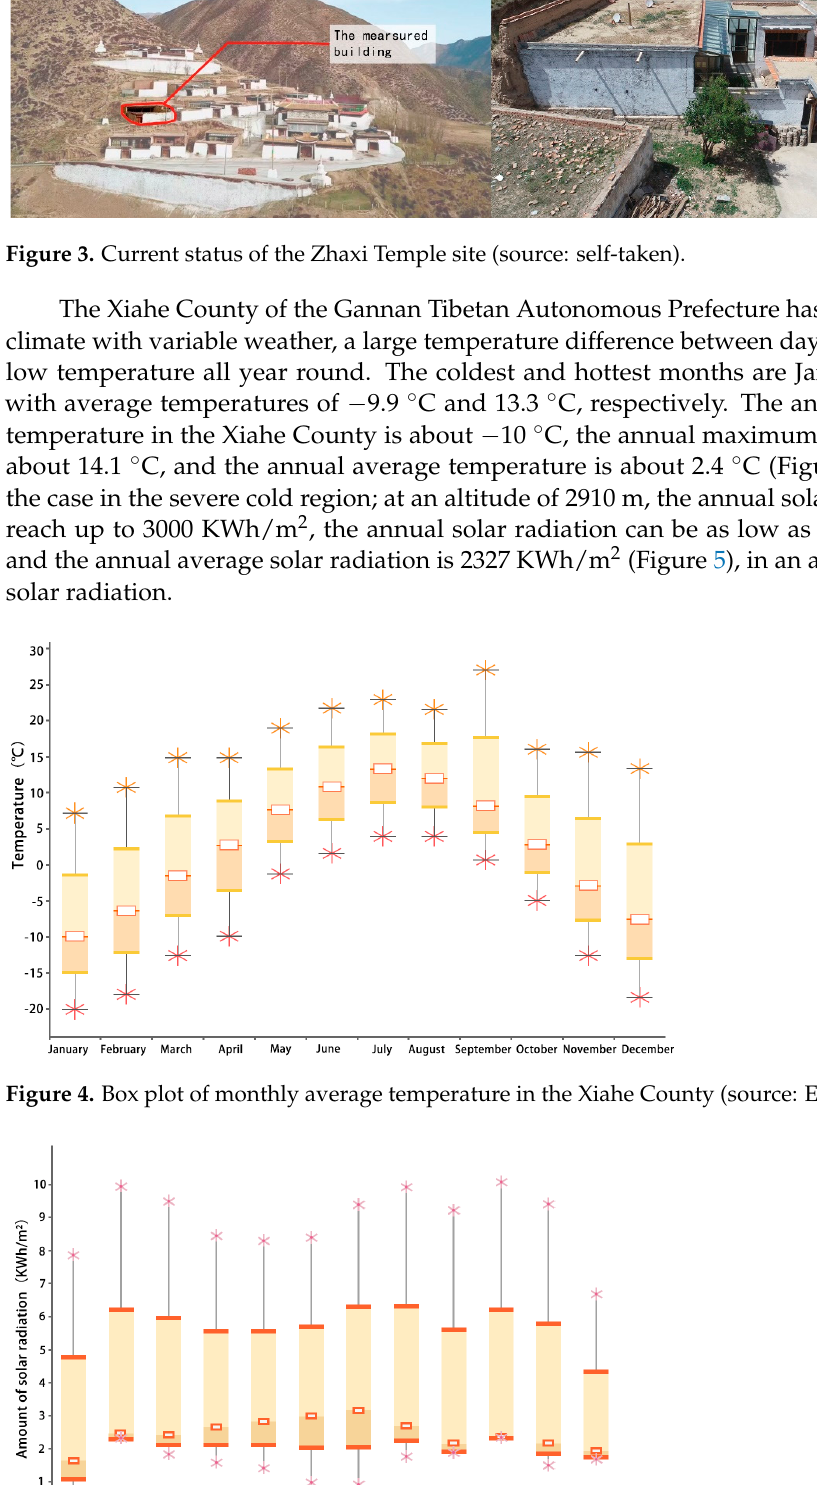
Figure 5. Monthly solar radiation box plot of the Xiahe County (source: Ecotect).